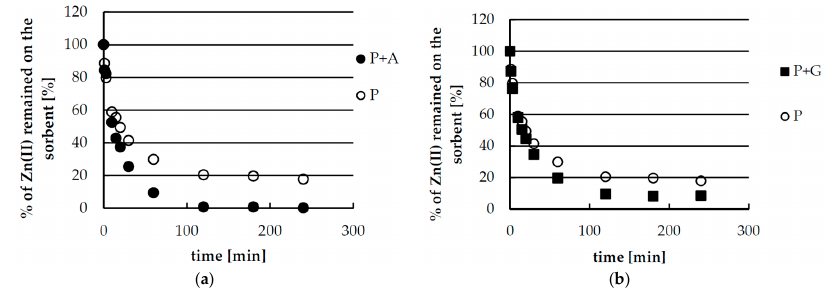
Figure 4. Comparison of zinc(II) ions desorption from pectin-based biosorbents (P + A—hybrid pectin biosorbent with agar, P + G—hybrid pectin biosorbent with guar gum, P—sole pectin biosorbent) using various acid solutions of various concentration. Mass of sorbent 0.03 g, volume of solution: 0.01 L, pH = 6, temperature 22 ± 1 °C, time of contact 24